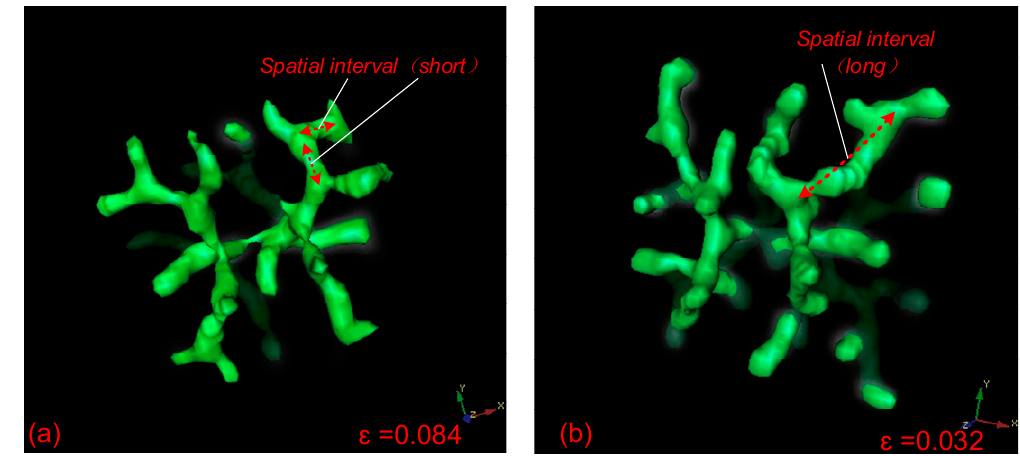
Figure 6. Comparison of the segment lengths of spatial intervals between sequential branching events with different parameter values. ( a ) When ε = 0.084, the spatial interval between sequential branching events is relatively short; ( b ) when ε = 0.032, the spatial interval between branches is relatively long. Parameters: c = 0.04, µ = 0.8, v = 0.08, ρ A = 0.03, ρ H = 0.0001, c 0 = 0.02, γ = 0.02, d = 0.008, e = 0.1, f = 10, D A = 0.1, D H = 0.26, D S = 0.06, ε = 0.084 or 0.032.